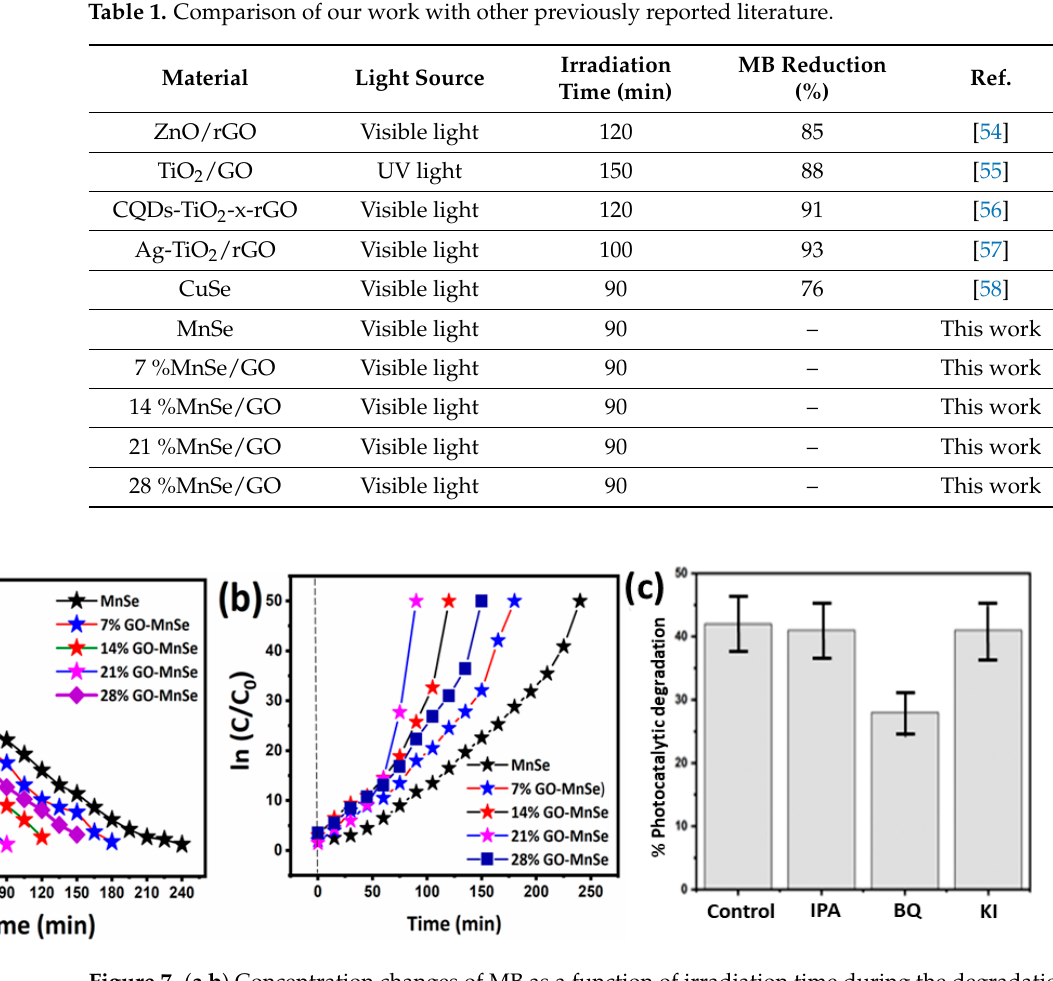
Figure 7. ( a , b ) Concentration changes of MB as a function of irradiation time during the degradation process by nanocomposites MnSe, 7% GO-MnSe, 14% GO-MnS, 21% GO-MnSe, and 28% GO-MnSe plots, and ( c ) photodegradation of MB over sepiolite in the presence of different scavengers, i.e., isopropanol (IPA), benzoquinone (BQ), and potassium iodide (KI).